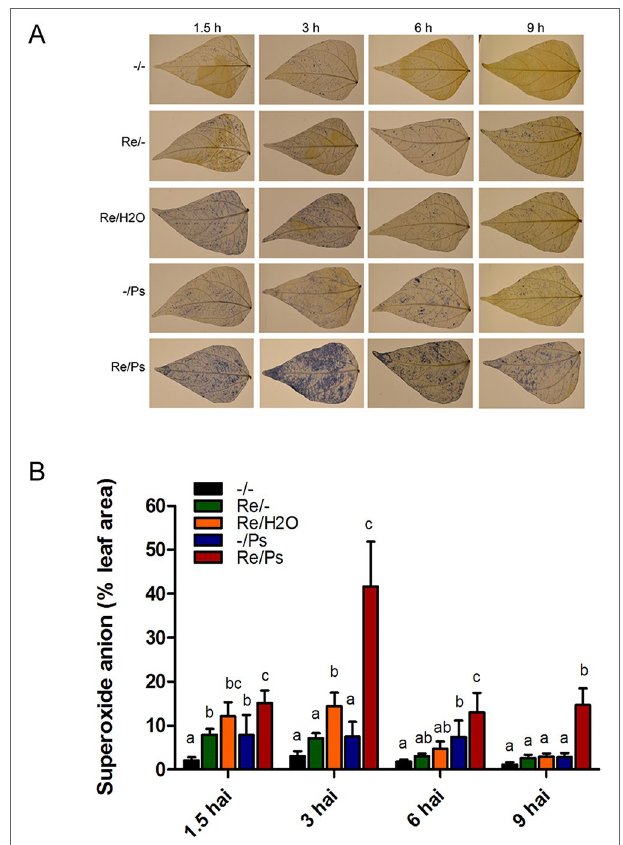
FIGURE 2 | Histochemical detection of superoxide anion in F0 common bean plants at 1.5, 3, 6, and 9 h after infection (hai). (A) Illustrative photographs from three independent experiments on Phaseolus vulgaris leaves from plants co-cultivated or not with Rhizobium etli , after exposure to PspNPS3121. (B) Quantification of O 2− was performed using the protocol described by Juszczak and Baier, 2014. Images were taken using a digital camera Nikon 5500 (Nikon Corp., Tokyo, Japan). Statistical significance was determined using one-way ANOVA followed by Tukey’s test, p < 0.05. Means with the same letter are not significantly different.